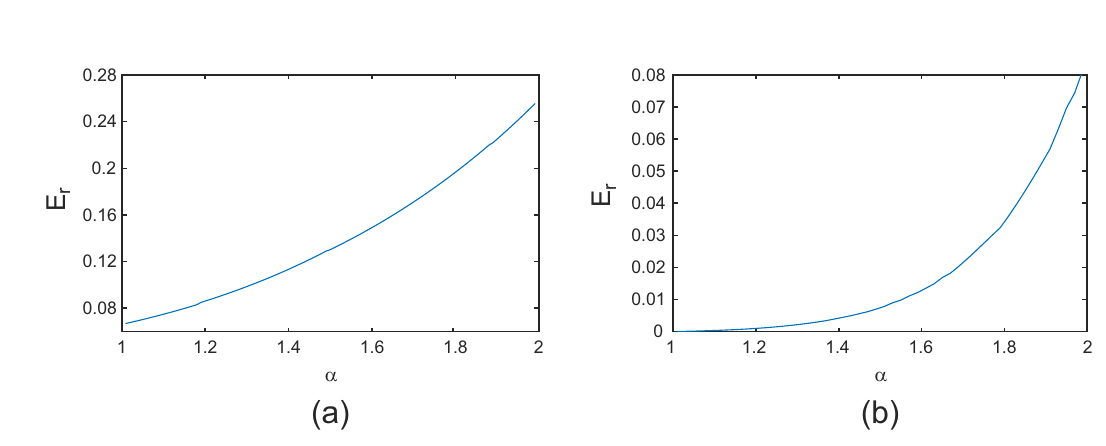
Figure 2: The variation of E r with α ( Example 1 ) . ( a ) δ